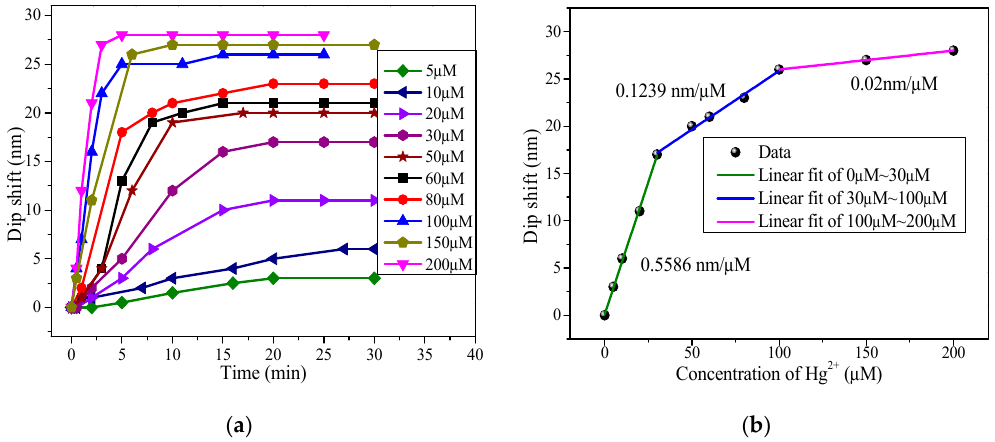
Figure 9. Resonant spectra ( a ) and linear fitting result ( b ) of the reflective fiber SPR sensor in the Hg 2+ concentration measurement.